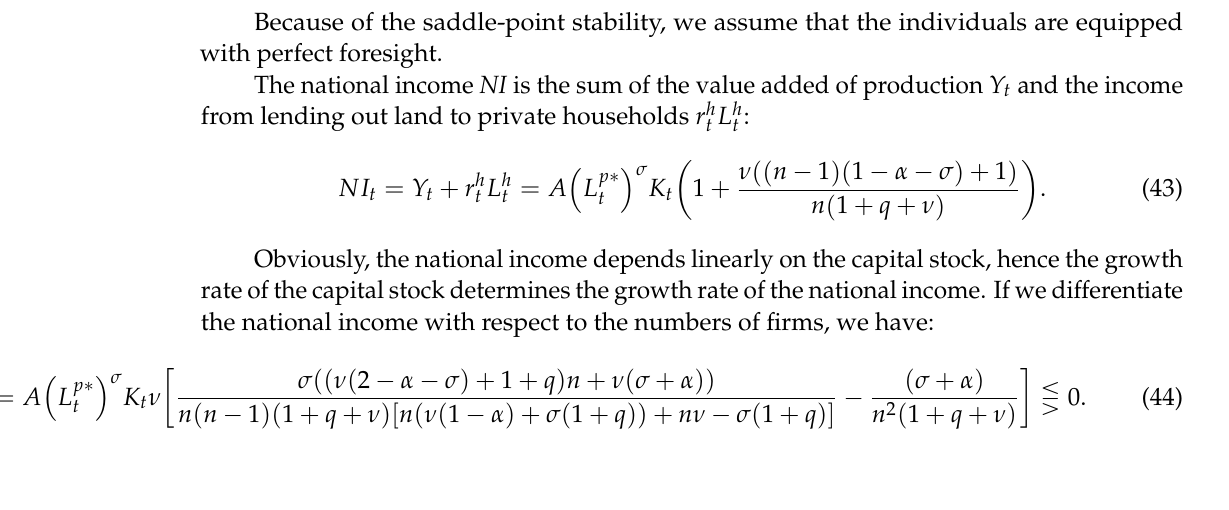
Figure 2. Price of land measured in terms of capital in t and t + 1.